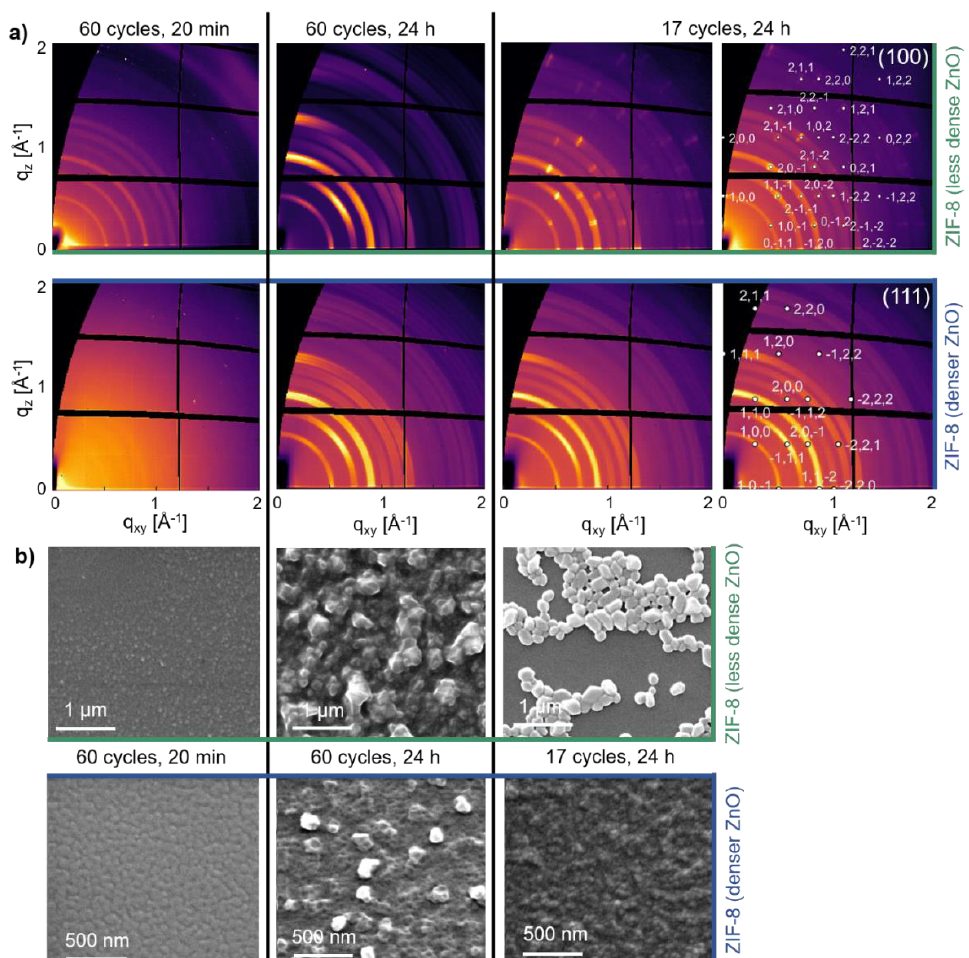
Figure 2. ( a ) ZIF-8 obtained after 20 min and 24 h of conversion from ZnO deposited for 60 and 17 cycles with densities of ρ = (4.6 ± 0.1) g/cm 3 and of ρ = (5.2 ± 0.2) g/cm 3 measured via grazing incidence X-ray diffraction. The diffraction patterns on the right are indexed with ZIF-8 reference data [44]; ( b ) Corresponding scanning electron microscopy images of the presented samples.